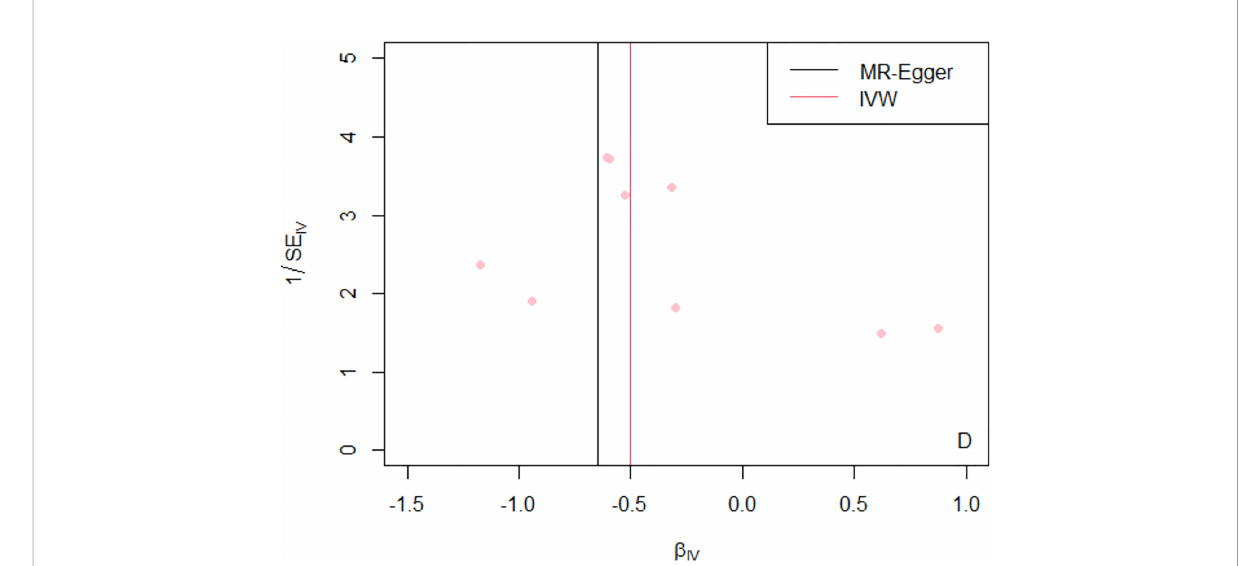
FIGURE 5 Funnel plot of MR analysis of telomere length on the risk of Graves ’ disease by using nine SNPs. The x-axis represents causal estimates (Wald ratios= b Y / b X ) for each SNP. The y-axis depicts the inverse of standard errors for the effect sizes for each SNP. The overall effect estimates are revealed by vertical lines when using the MR-Egger and IVW approaches (black and pink lines, respectively). SE, standard error; IV, instrumental variable; IVW, inverse variance weighted; MR, Mendelian